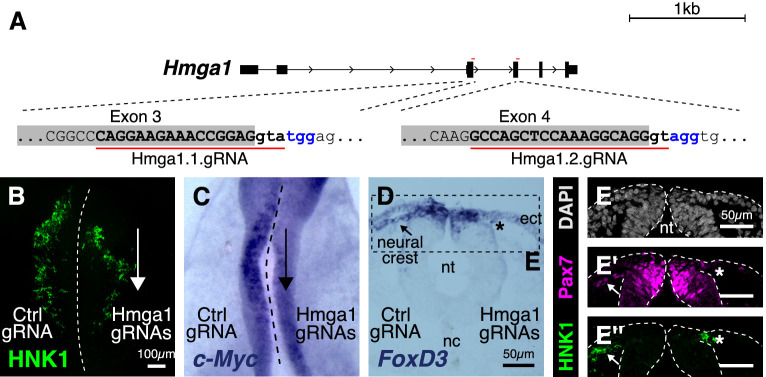
Knocking out Hmga1 in gastrula stage embryos.(A) The genomic locus of Hmga1 in the chick genome. Two gRNAs, one targeting the splice donor site of exon three and another one targeting the splice donor site of exon four were designed to knock it out using CRISPR-Cas9. The protospacer adjacent motifs for both gRNAs lie in the intronic regions (highlighted in blue). (B) Electroporated embryos were allowed to develop until HH9+ and immunostained for the migratory neural crest marker HNK1. In the absence of Hmga1, neural crest cells failed to migrate properly on the experimental side. (C) Hmga1 knockout results in reduced c-Myc expression in premigratory neural crest. (D–E’’) Transverse section through a representative Hmga1-knockout embryo with FoxD3 mRNA labeled using in situ hybridization. Neural crest cells migrated normally on the control (arrow) compared to the knockout side (asterisk). While the thickness of the neural tube (E) was unaffected on the knockout side, the expression of Pax7 (E’) and HNK1 (E’’) was also reduced.